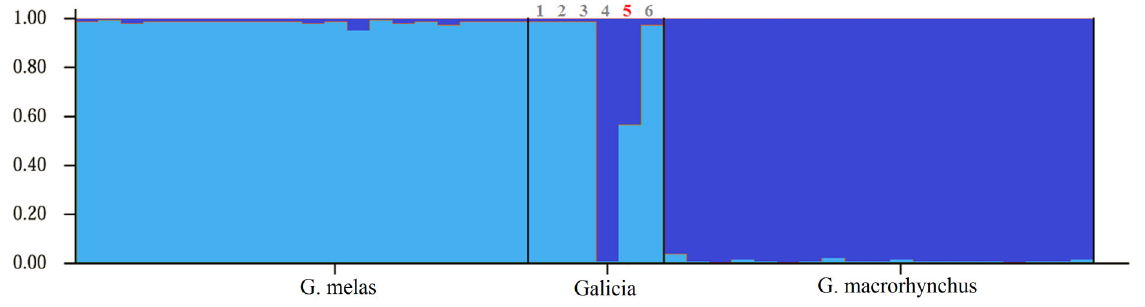
Figure 2. Individual membership of pilot whale samples from the considered regions estimated with STRUCTURE software. Each vertical bar represents one individual. Membership to G. macrorhynchus in dark blue and to G. melas in light blue. The numbers identifying stranded individuals are indicated above the corresponding vertical bars; the Post-F1 hybrid is in red.